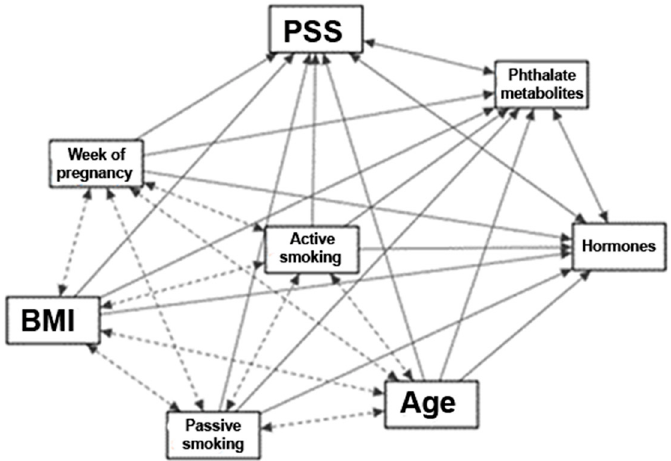
Figure 1. Path diagram explaining the potential associations between the concentrations of hormones, phthalate metabolites, PSS score and confounding variables (age, BMI, week of pregnancy, active and passive smoking). Solid arrow represents association with between the main variables (concentrations of hormones, phthalate metabolites, PSS score) or between confounding variable and main variables. Interrupted arrow represents association between confounding variables.